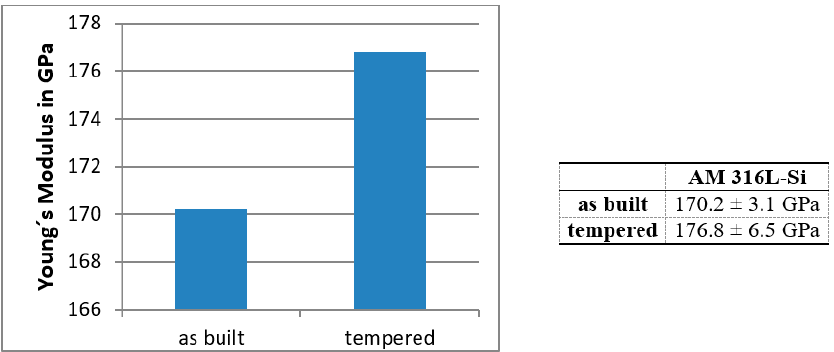
Figure 18. Determined average Young’s modulus for seven specimens.